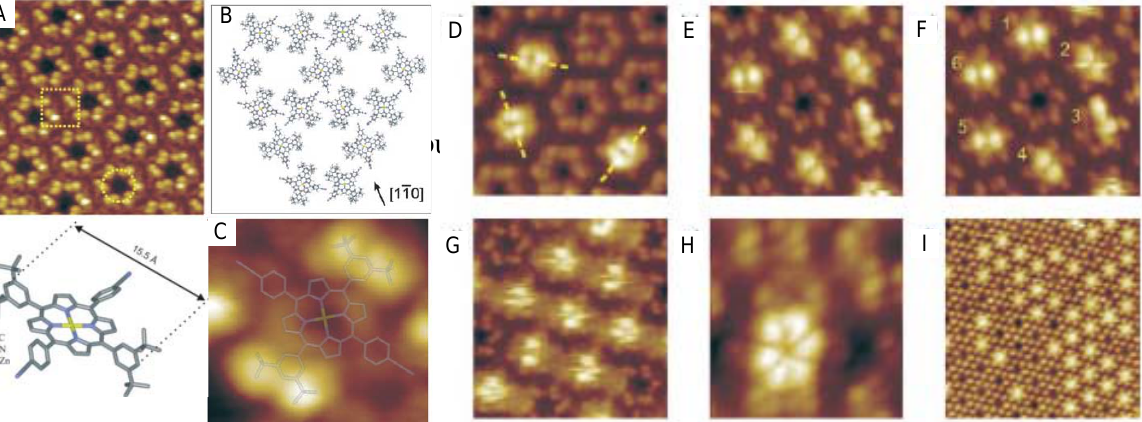
Figure 14 . Sequential STM images (A, C-I) and the schematic illustration (B) of a porphyrin derivative on Cu(111) at different temperatures. Reproduced with permission from reference [64]. Copyright Wiley-VCH Verlag GmbH & Co.